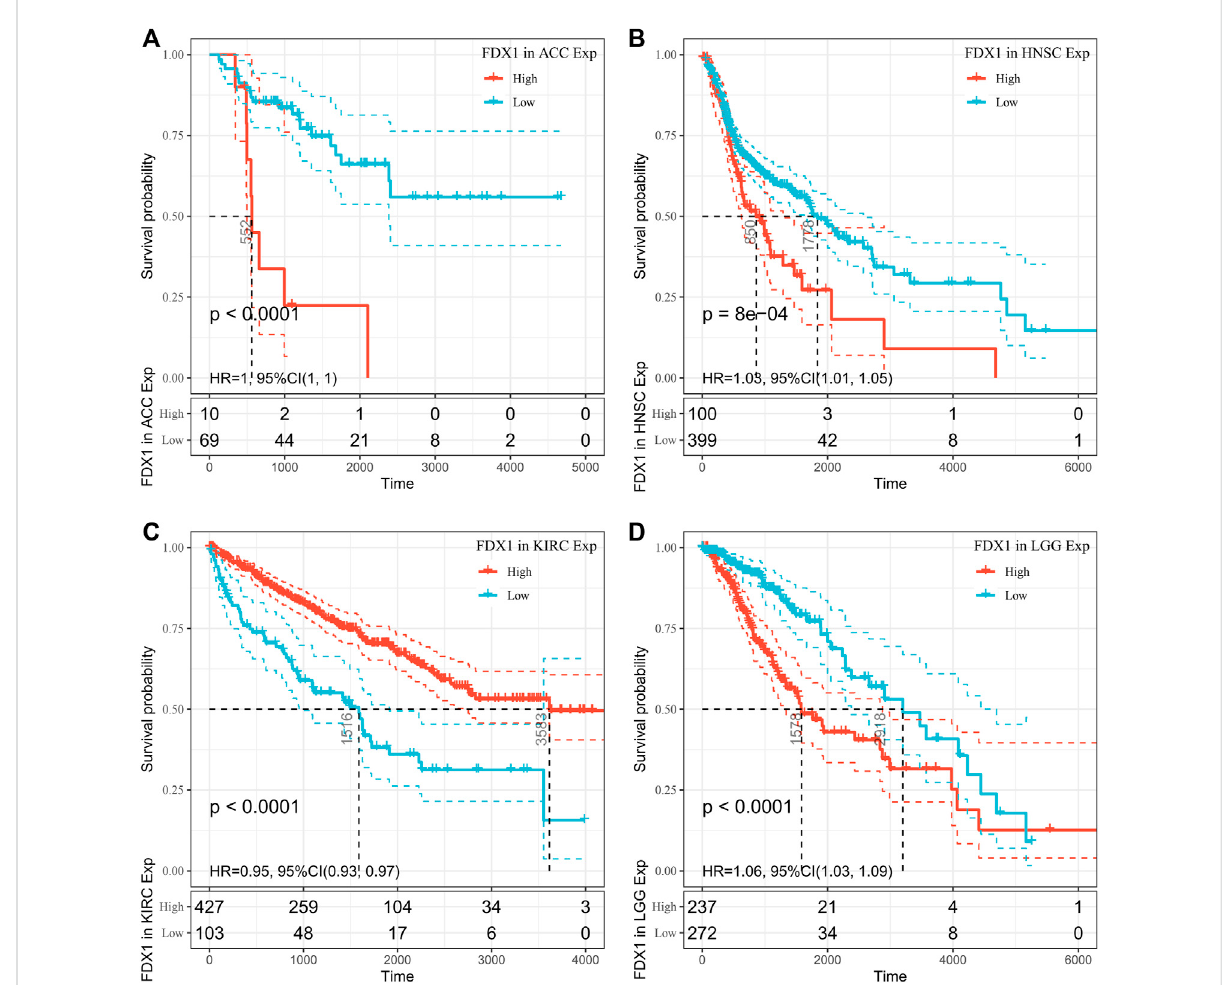
FIGURE 3 Overall survival (OS) difference of high and low FDX1 mRNA expression groups in signi fi cantly prognostically relevant tumors from the Cancer Genome Atlas database (by median expression dichotomy). (A) OS difference of ACC groups. (B) OS difference between HNSC groups. (C) OS difference between KIRC groups. (D) OS difference of LGG groups. p < 0.05 was regarded signi fi cant, with a dashed line of 95%